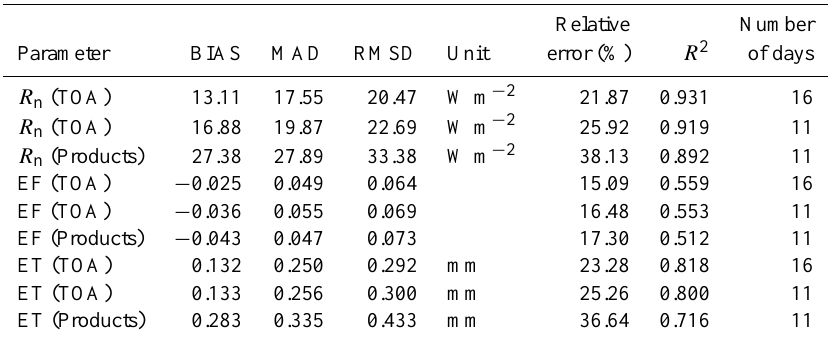
Table 4. Statistical results for the estimated R n , EF and ET using MODIS TOA radiances and MODIS products in comparison with obser- vations at Nanchang station.